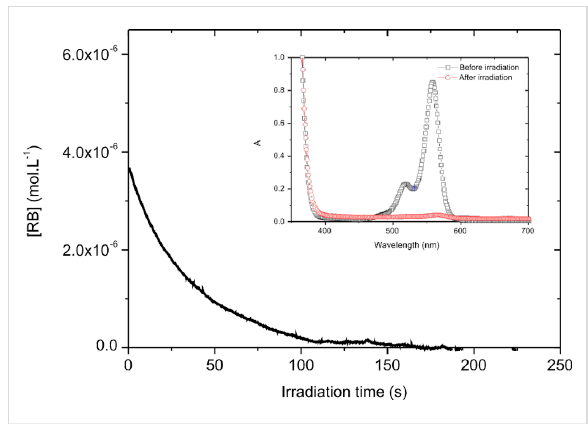
Figure 1: Evolution of RB concentration as a function of irradiation time ( λ = 532 nm, 9 mW·cm − 3 ); insert: absorption spectra obtained before and after